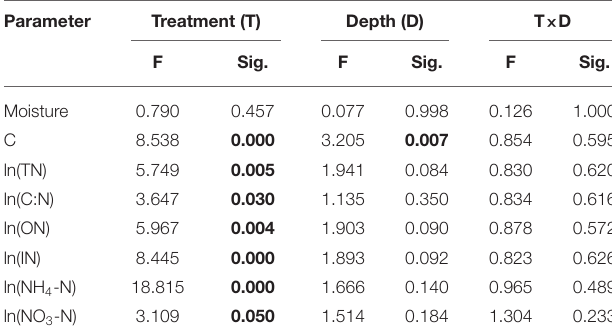
TABLE 2 | Results of the two-way ANOVA for the effect of treatment (T) and soil depth (D) on the variation of soil moisture, soil carbon (C) concentration, soil total nitrogen (TN) concentration, soil C:N ratio, soil organic-N (ON) concentration, soil inorganic N (IN) concentration, ammonium N (NH 4 -N) concentration, and nitrate N (NO 3 -N)